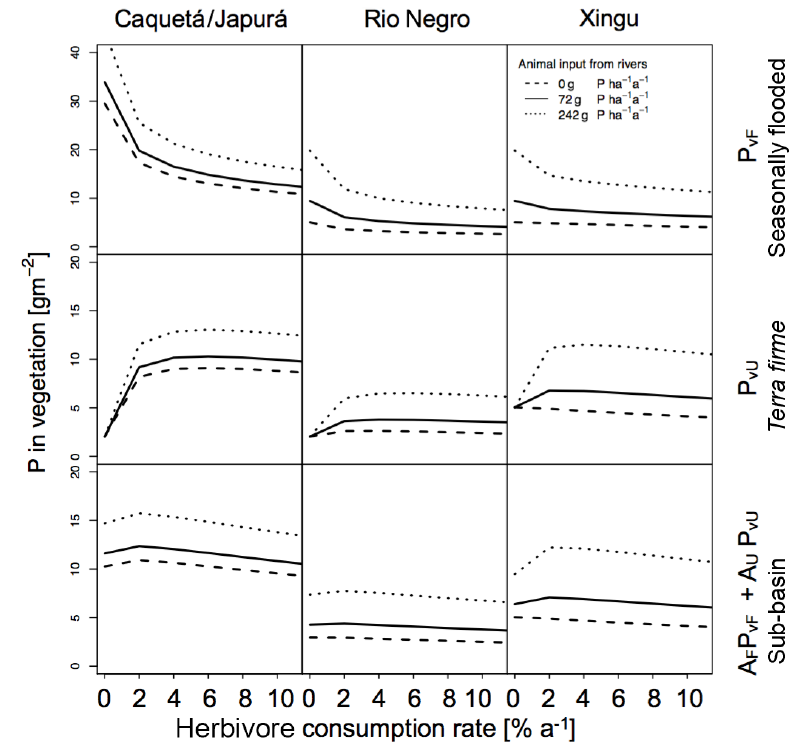
Figure 6. Sensitivities of herbivory on P in vegetation for the three sub-basins with different terrestrial piscivores P inputs. Effect of herbivory rates on P in vegetation (gPm − 2 ) for the three sub-basins (columns) at seasonally flooded and terra firme ecosystems and on the sub-basin scale (rows). The different line types refer to different input estimates to the flooded ecosystem by terrestrial piscivores (none, otters only, otters and other species). Simulations were run without